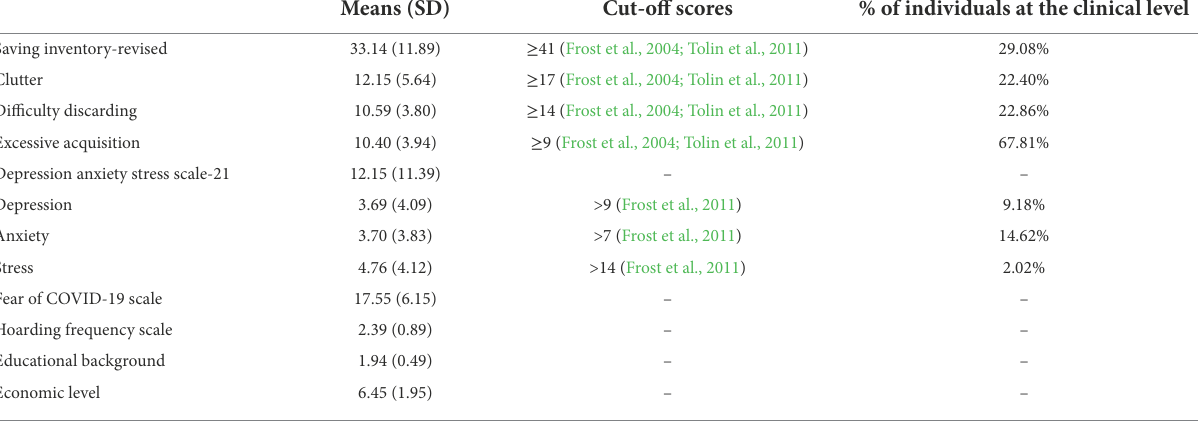
TABLE 1 Summary of participants’ clinical